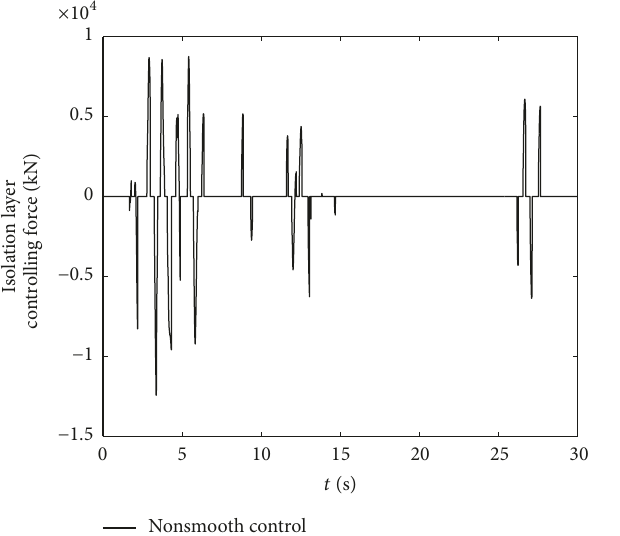
Figure 2: Control force response of isolation layer.